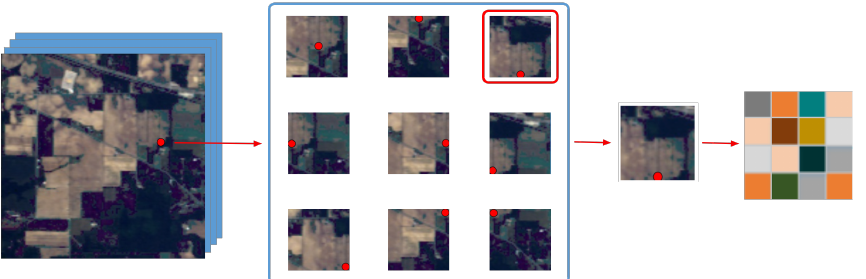
Figure 1. Process of the SPCM method. Each pixel of HSI generates nine windows, and then the optimal one is selected. The red point is the pixel to be processed, and is collectively referred to as the target pixel in the following text. A correntropy matrix is constructed from all pixels in this optimal window. The input to the SPCM method is a single pixel and the output is a correntropy